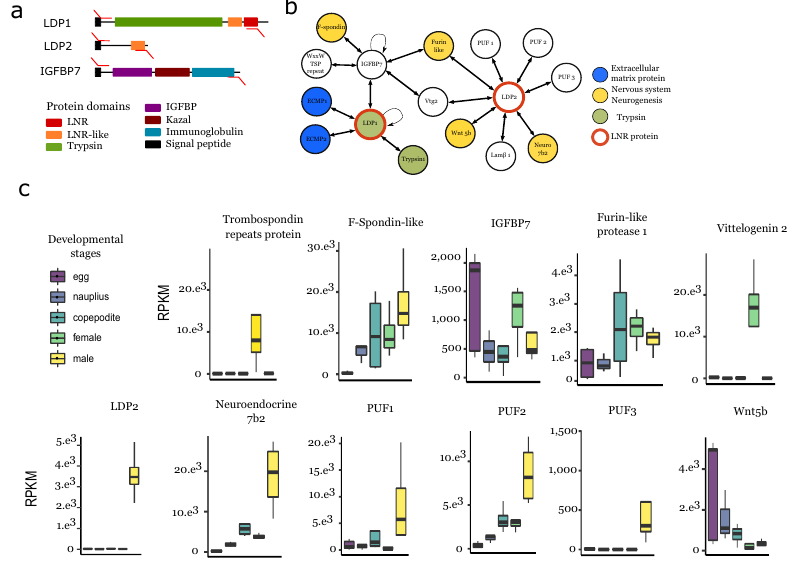
Figure 5. Protein–protein interaction of LNR-containing proteins in the O. nana male proteome. ( a ) Structure and expression of the PPI candidates. The red arrows represent PCR primers. ( b ) PPI network of LDPGs obtained by yeast two-hybrid assays. Lam β 1: Laminin subunit beta 1. Vtg2: Vitellogenin 2. PUF: protein of unknown function. ( c ) RPKM-normalized expression in the five developmental